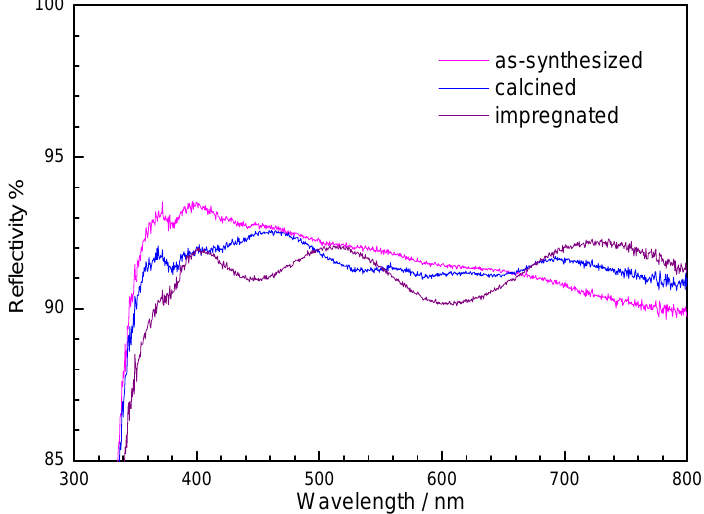
Figure 10. UV-visible spectra of the Co(II)-containing silica films: ( a ) as-synthesized; ( b ) after thermal treatment at 500 °C; ( c ) after impregnation with the ferricyanide acidic solution.